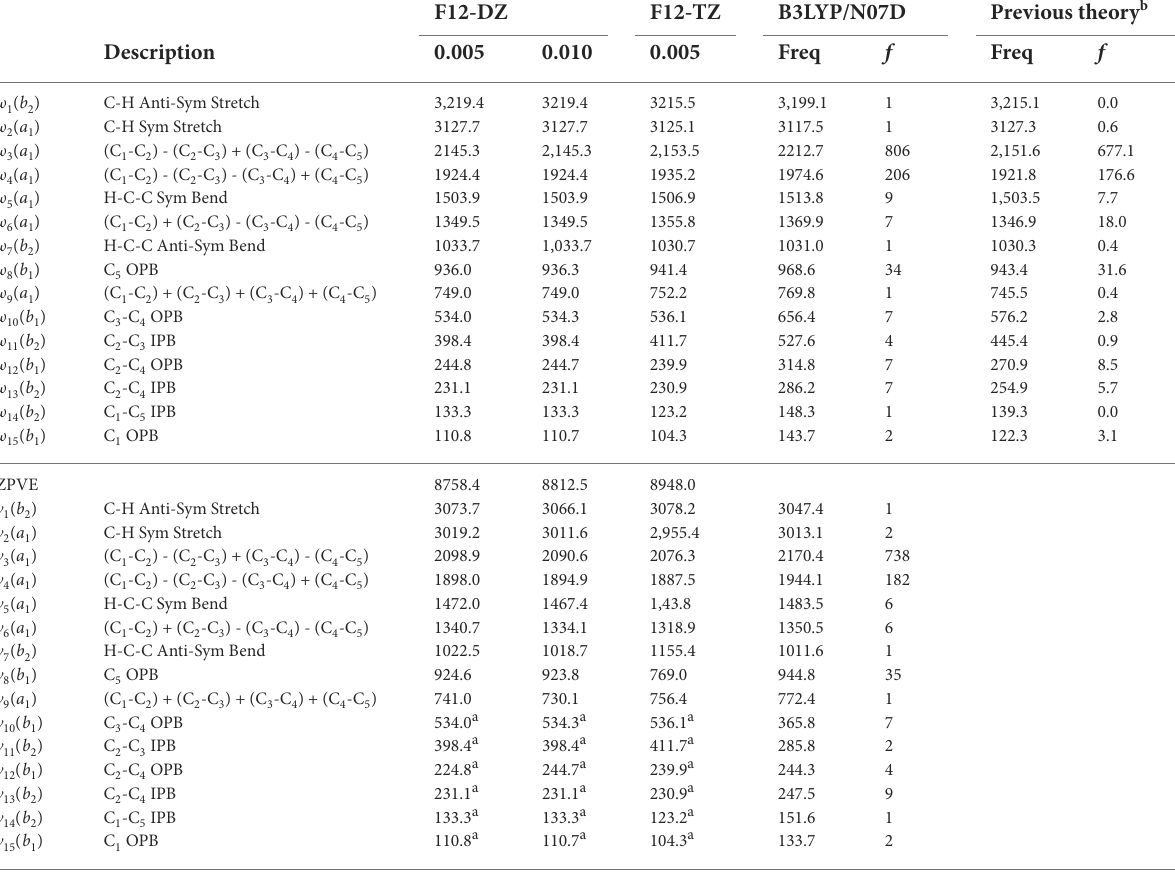
TABLE 5 F12-DZandF12-TZharmonicandfundamentalvibrationalfrequenciesandB3LYP/N07Dintensities(inkm mol − 1 )of l -C 5 H 2 comparedtoprevious theorycomputedatthefc-CCSD(T)/cc-pVTZleveloftheory b